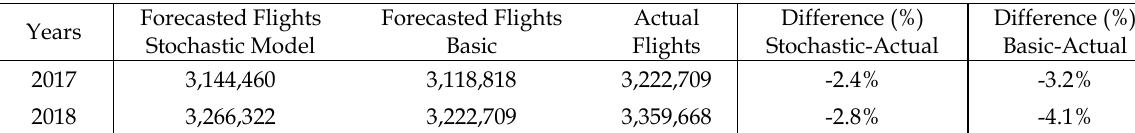
Table B4. Actual and forecasted number of